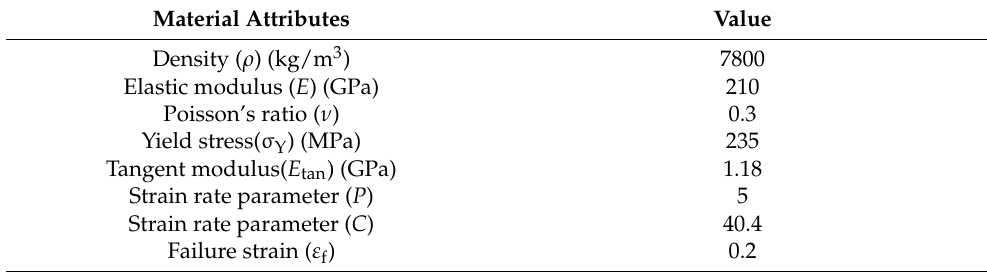
Table 3. Material attributes of the pipe.